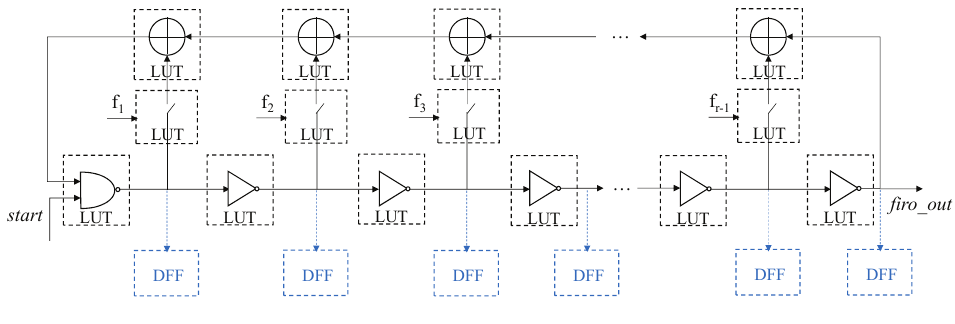
Figure 3: The implementation of a FIRO on